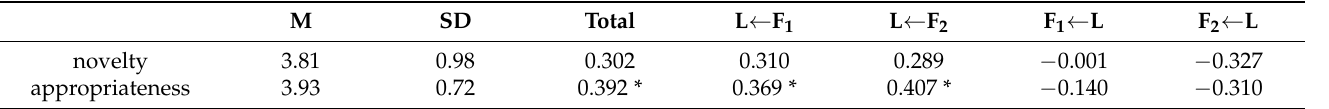
Table 3. Correlation between the frequency of turns of the emergent leader and the indicators of group